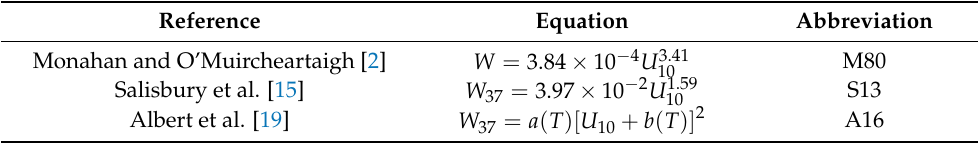
Table 1. The three W parameterization schemes used in the paper and their abbreviations, W 37 is the satellite-derived W data at 37 GHz, T is the sea surface temperature, U 10 is the wind speed at 10 m. The a(T) and b(T) are formulas related to T , see reference for